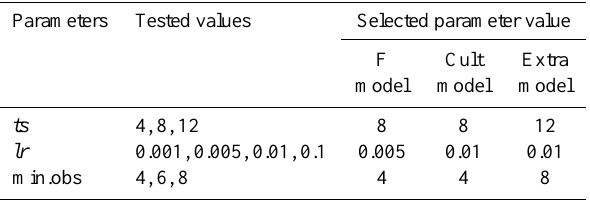
Table 1. Tested and optimal values for the ts , lr , min.obs parameters of the three boosted regression trees models. The optimal values were selected as resulting in the best <R 2 ext > , obtained through the cross validation